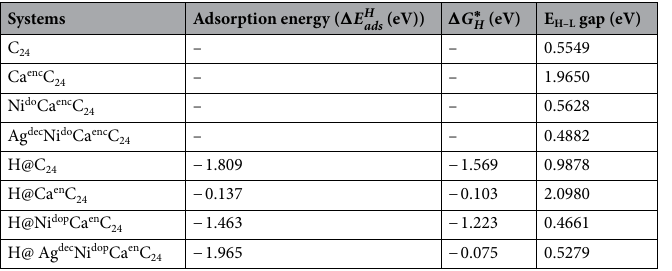
Table 7. Summary of the tabulated calculated key factor results for electrocatalytic hydrogen evolution reaction